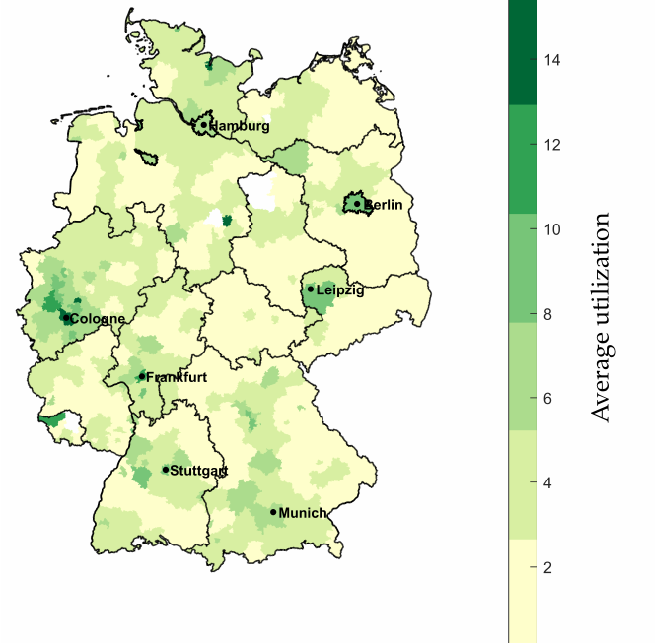
Figure 2. Spatial distribution of the average utilization of CPs per region in Germany. The measure for the utilization is calculated using the average duration in hours multiplied with the average number of charging events per week. The value is calculated for every CP and then average over all CPs within